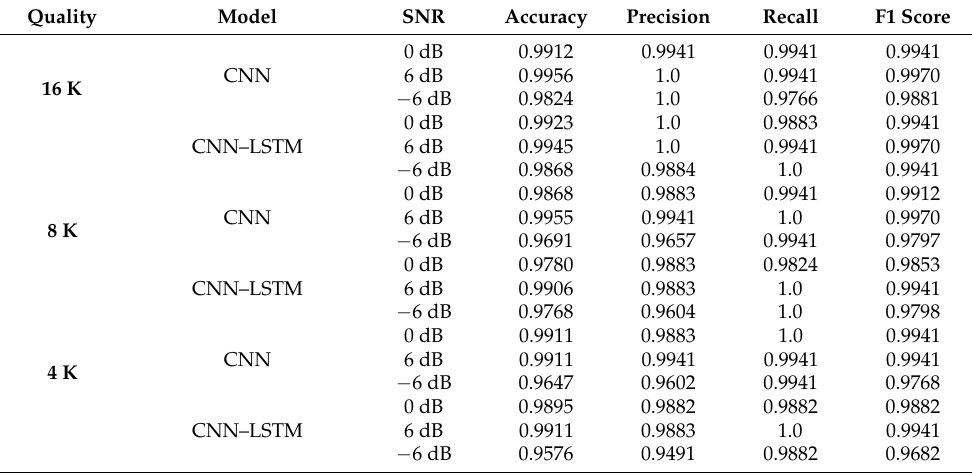
Table 4. Result of training on the CNN and CNN–LSTM models by performing Hilbert transform for slider data.